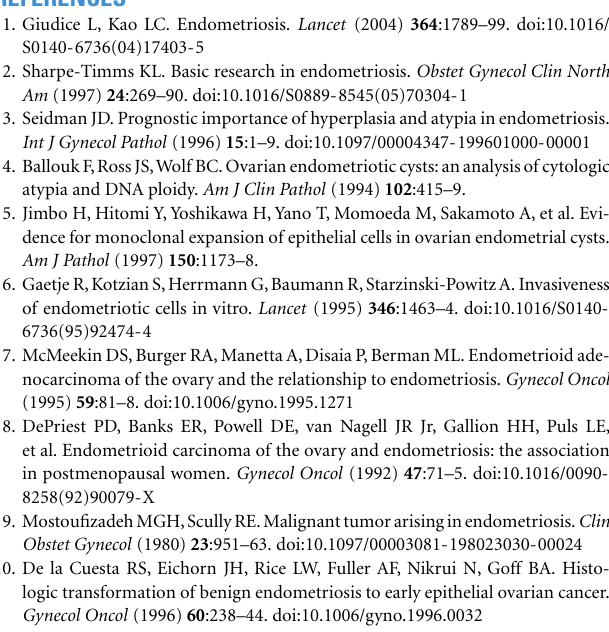
FIGURE 8 | Immuno-histo-chemical analysis of ectopic endometrial glands and embryonic ducts in fetal reproductive tract . Immunolabeling with anti-PR antibody of uterine cavity wall lining cells [ (A) arrows]. Immunostaining of the fetal ectopic glands located in the uterine myometrium with anti-PR (B) , anti ER-alpha (C) , and anti CD10 antibodies (D) .